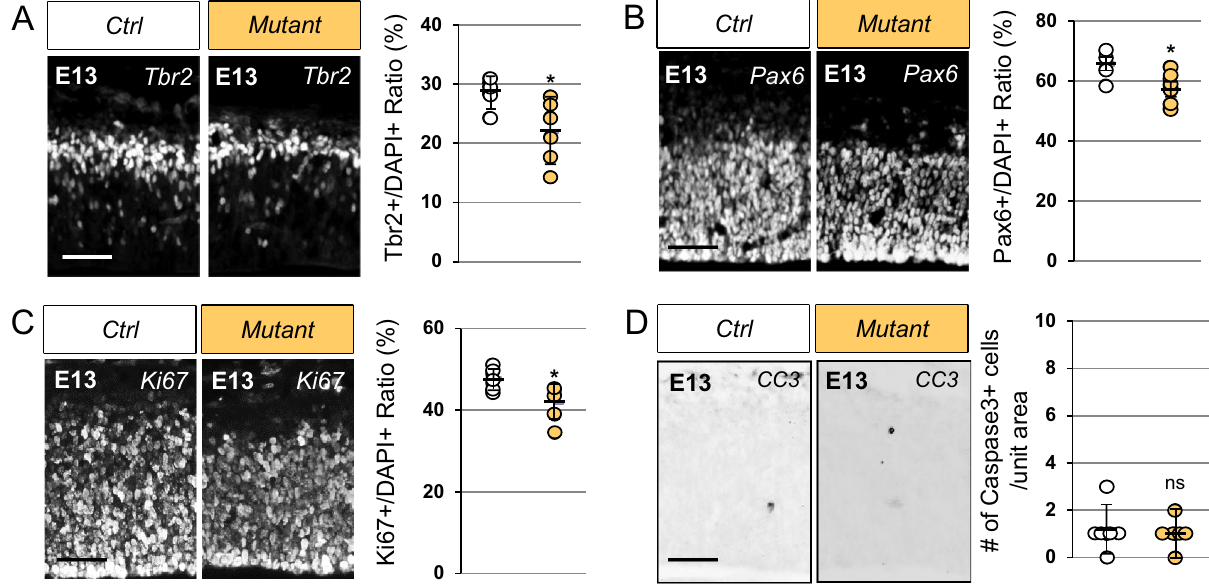
Figure 4. Reduction in the number of neural precursor cells in Emx1-Scrib −/− mutant cortices is associated with proliferation but not apoptosis defects. ( A – D ) Representative immunostaining of Tbr2 ( A ), Pax6 ( B ), Ki67 ( C ) and activated cleaved caspase 3 (CC3) ( D ) on coronal sections from embryonic stage E13 Emx1-Scrib −/− cKO brains. Cells were counted in 312.35 μm-wide cortical areas from three mutants and three controls from two different litters. Quantification of Tbr2-, Pax6- and Ki67-positive cells is shown as a percentage (see “Materials and methods”). The proportion of Tbr2- and Pax6-positive progenitors as well as Ki67-positive cells is decreased in Emx1-Scrib −/− cKO embryonic brains. No variation of activated caspase3-positive apoptotic cells is observed in Emx1-Scrib −/− mutant cortices. Statistical analysis via a two-tailed t test (*P < 0.05) using 6 measurements per genotype. Error bars indicate the SD. Scale bar 50